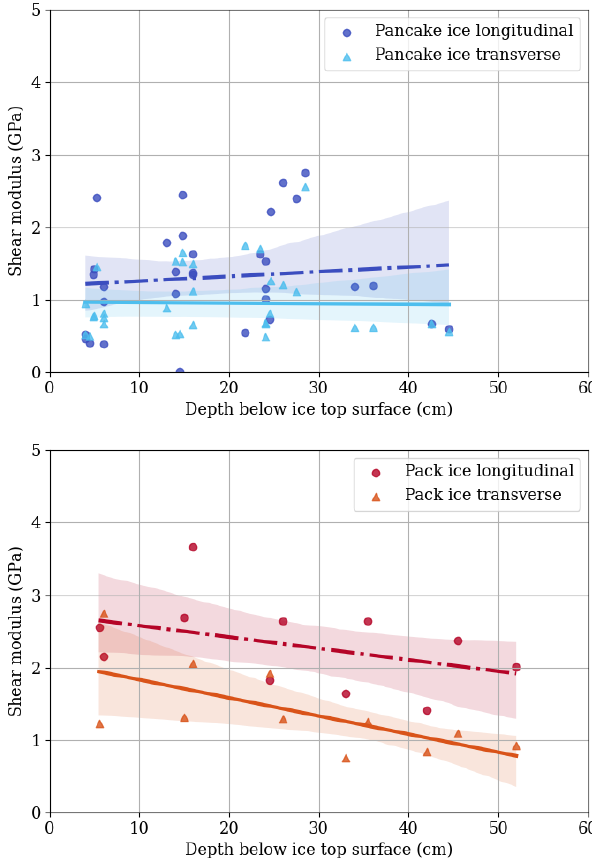
Figure 14. Longitudinal and transverse Young’s modulus for pan- cake ice cores M01-US-01-A, M01-US-01-B, M01-US-01-C, M01- US-01-D, M01-US-02-A, M01-US-02-B, M01-US-02-C and M01- US-02-D as well as consolidated pack ice cores M03-US-01-A and M03-US-02-A as a function of the percentage porosity of the total volume. The shading indicates the 90th-percentile confidence in- tervals. “Langleben and Pounder” refers to Langleben and Pounder